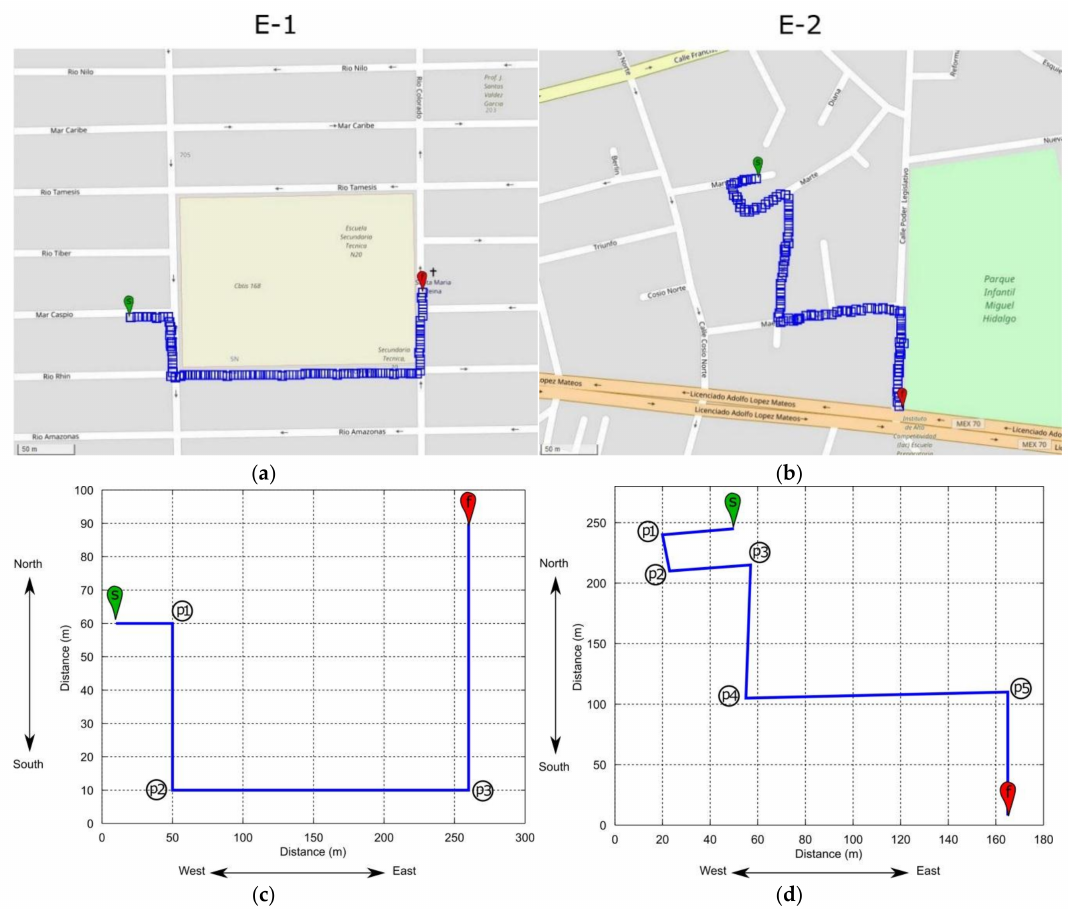
Figure 5. Examples of subject performance in the outdoor navigation task. ( a ) Subject A in E-1; ( b ) Subject B in E-2. GPS data in these plots were downsampled by a factor of 10. The corresponding walking paths and waypoints correspond to where the instructions led: ( c ) E-1 and ( d ) E-2.